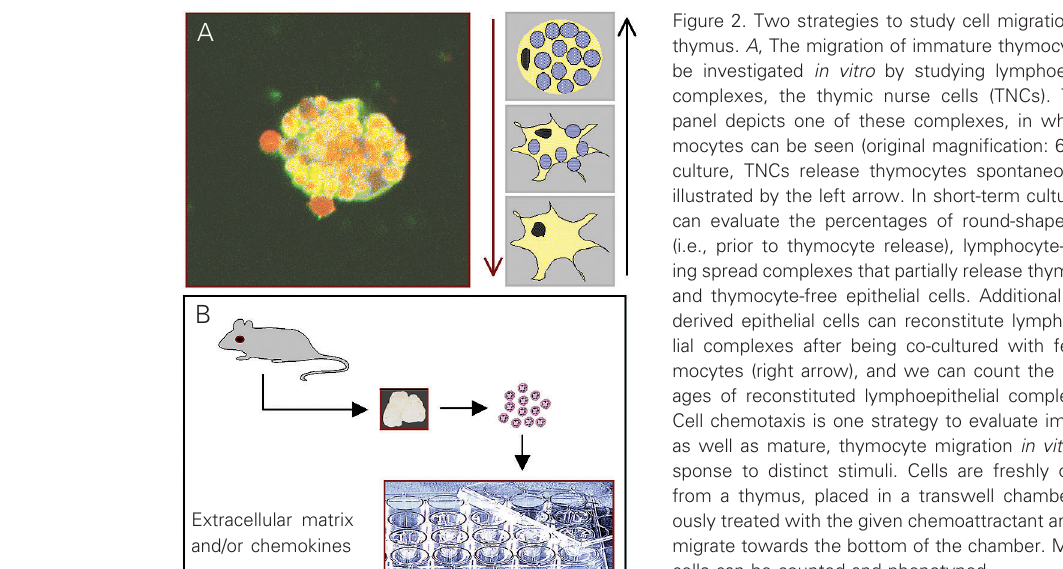
Figure 2. Two strategies to study cell migration in the thymus. A , The migration of immature thymocytes can be investigated in vitro by studying lymphoepithelial complexes, the thymic nurse cells (TNCs). The left panel depicts one of these complexes, in which thy- mocytes can be seen (original magnification: 600X). In culture, TNCs release thymocytes spontaneously, as illustrated by the left arrow. In short-term cultures, we can evaluate the percentages of round-shaped TNCs (i.e., prior to thymocyte release), lymphocyte-contain- ing spread complexes that partially release thymocytes, and thymocyte-free epithelial cells. Additionally, TNC- derived epithelial cells can reconstitute lymphoepithe- lial complexes after being co-cultured with fetal thy- mocytes (right arrow), and we can count the percent- ages of reconstituted lymphoepithelial complexes. B , Cell chemotaxis is one strategy to evaluate immature, as well as mature, thymocyte migration in vitro in re- sponse to distinct stimuli. Cells are freshly obtained from a thymus, placed in a transwell chamber previ- ously treated with the given chemoattractant and led to migrate towards the bottom of the chamber. Migrating cells can be counted and